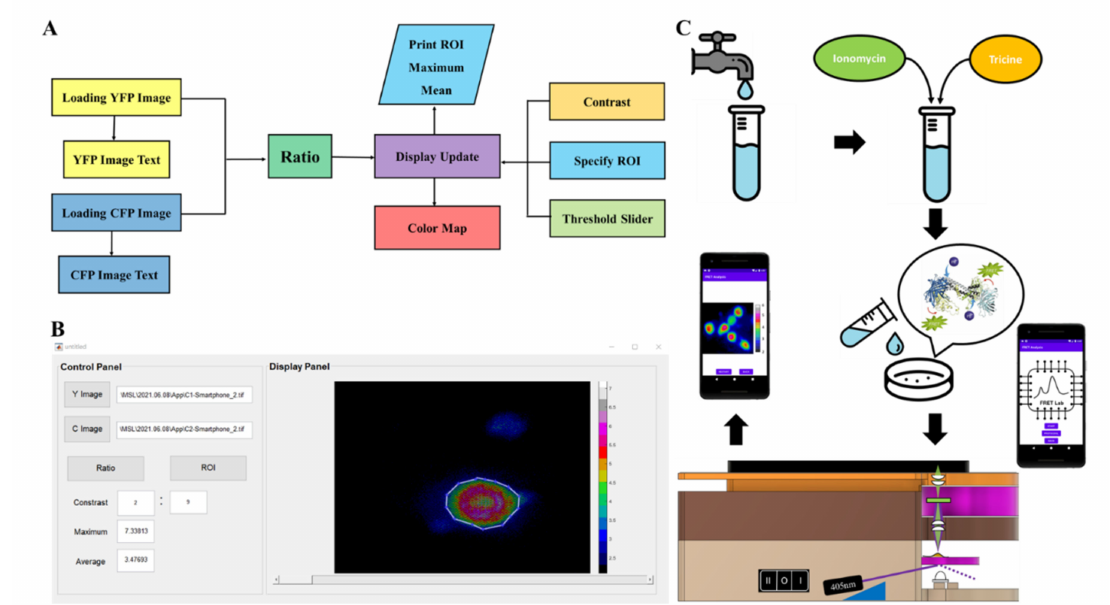
Figure 2. Processing of fluorescence images in pMet-lead. ( A ) Flowchart of the computational window graphical user interface (GUI) for ratio color imaging. After image input (loading) of YFP and CFP, select ‘ratio’ to make and save the ratio images to temporary memory sites. The calculated ratios will be displayed in a rainbow color format (display update; color map; maximum mean). The ranges of selected regions of interest (ROIs) can be manually adjusted to show the best present status (specify ROI; contrast; threshold slider). ( B ) Screen shot of the GUI for the FRET-based device interface during Pb sensing. The ratio color bar represents YFP/CFP ratios from 2 (black) to 7 (white). ( C ) The whole procedure for on-site Pb sensing with